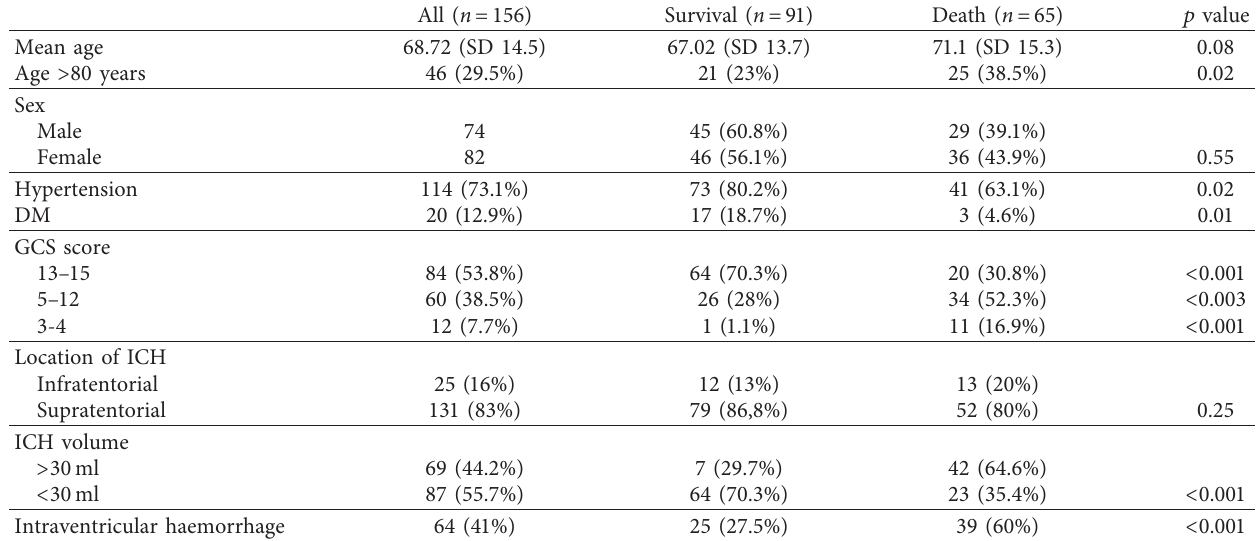
Table 1: Univariate analysis of patient characteristics.